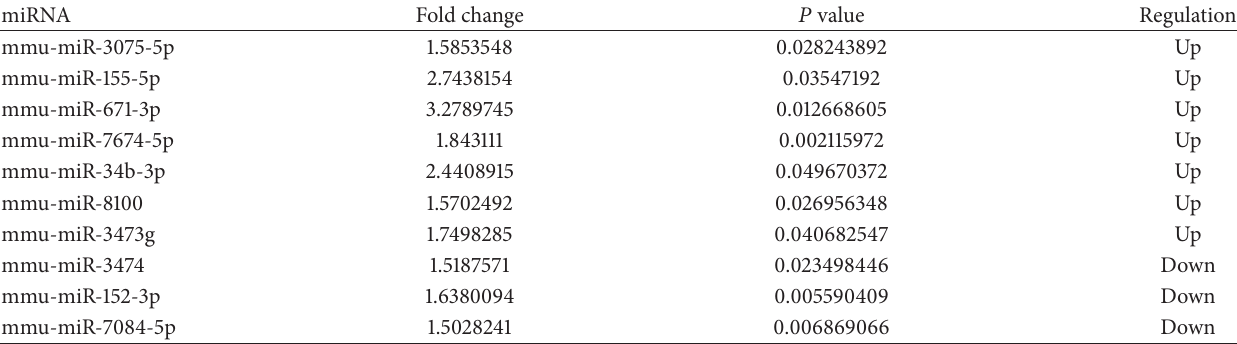
Table 2: Differentially expressed miRNAs in Kupffer cells with or without LPS stress.